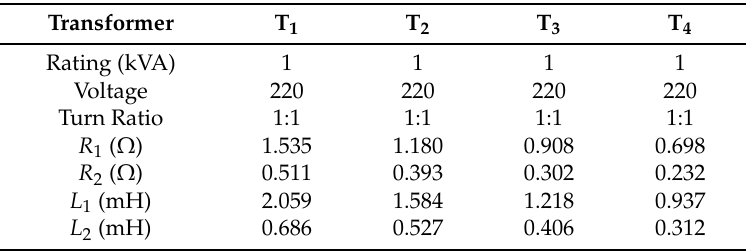
Table 2. Parameters of investigated load transformers.